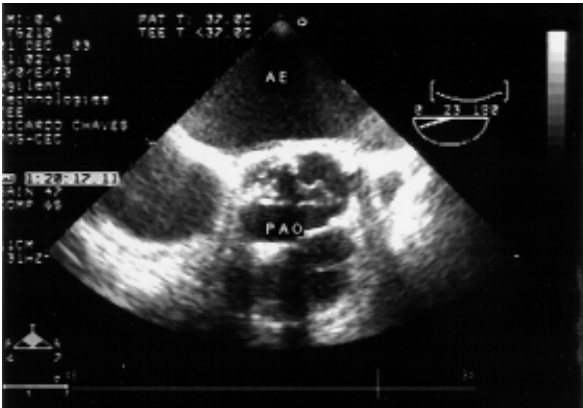
Fig. 6 – EcoDopplercardiograma transesofágico intra-operatório do caso 2. Prótese “Less Stented” com abertura e fechamento